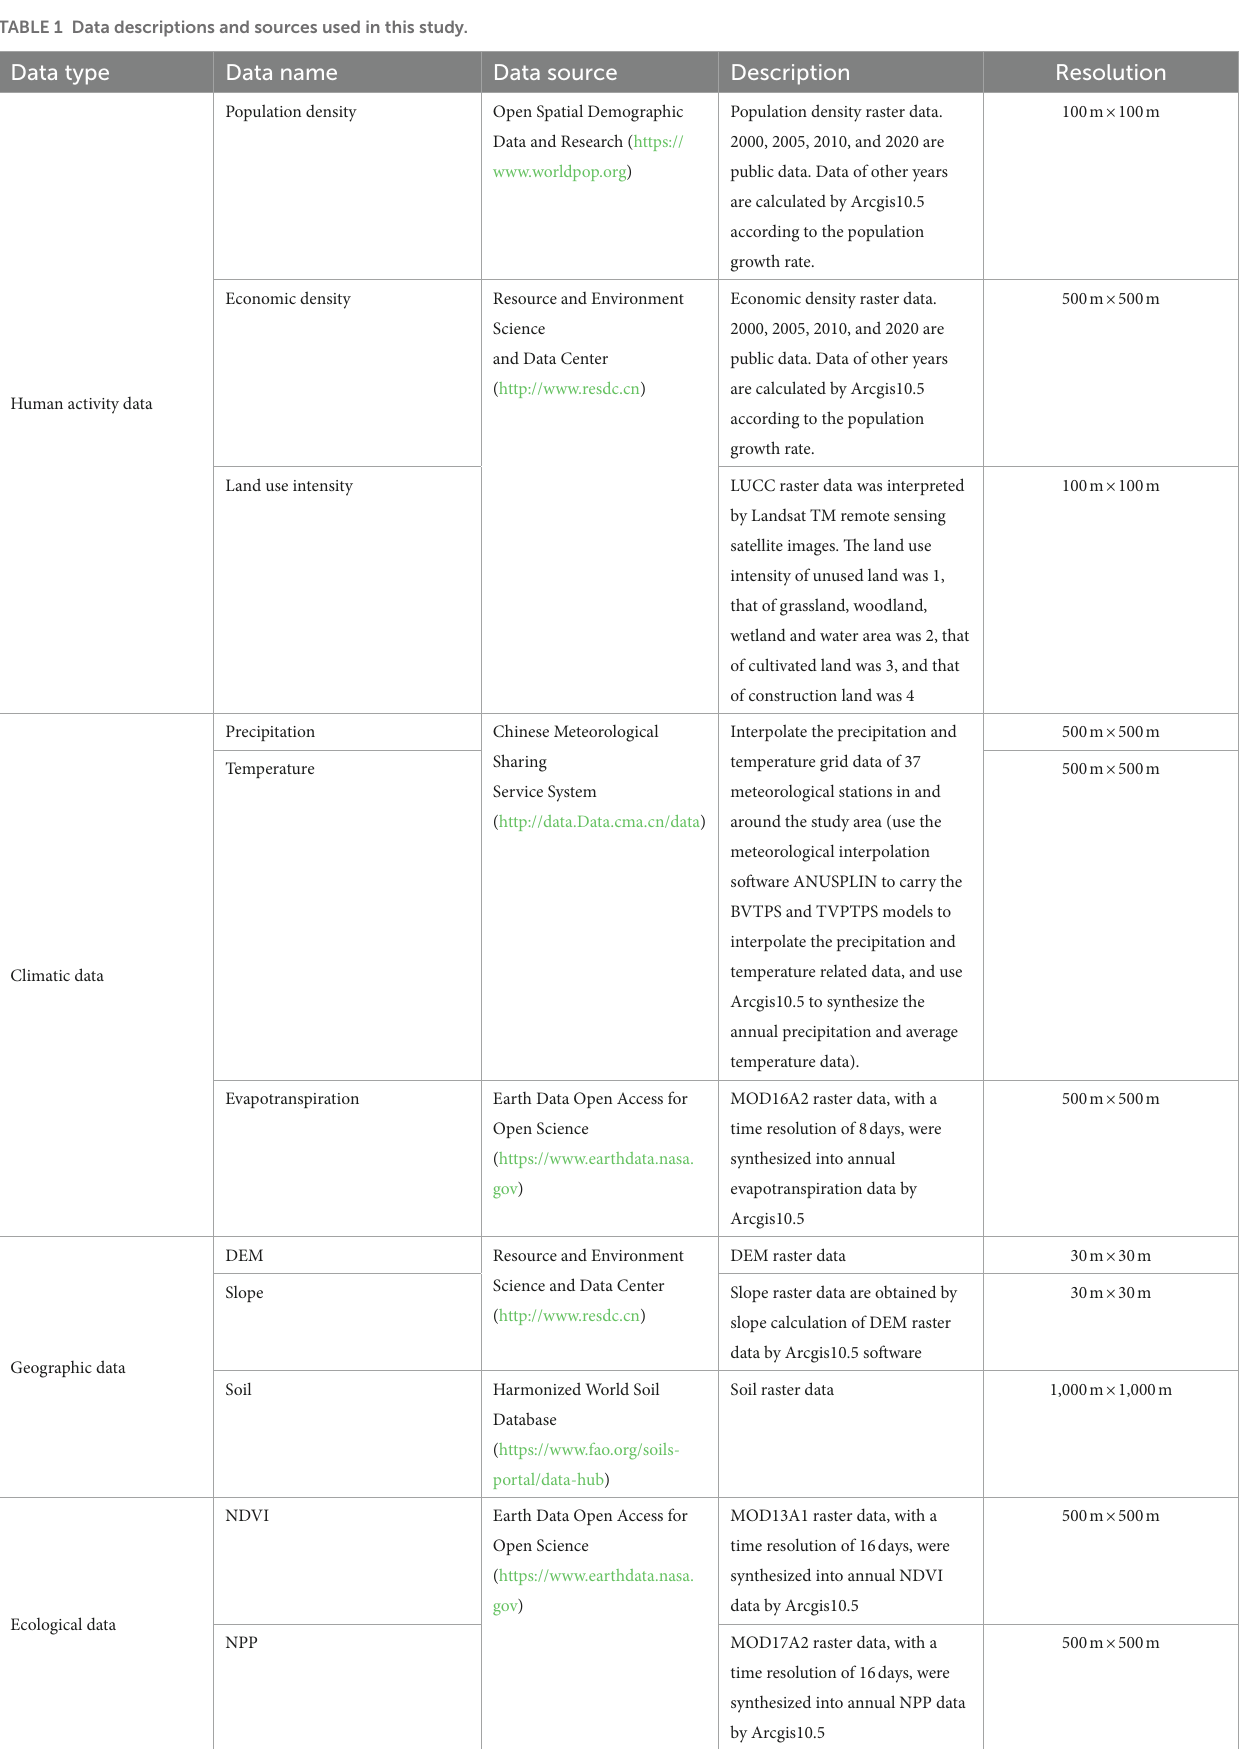
TABLE 1 Data descriptions and sources used in this